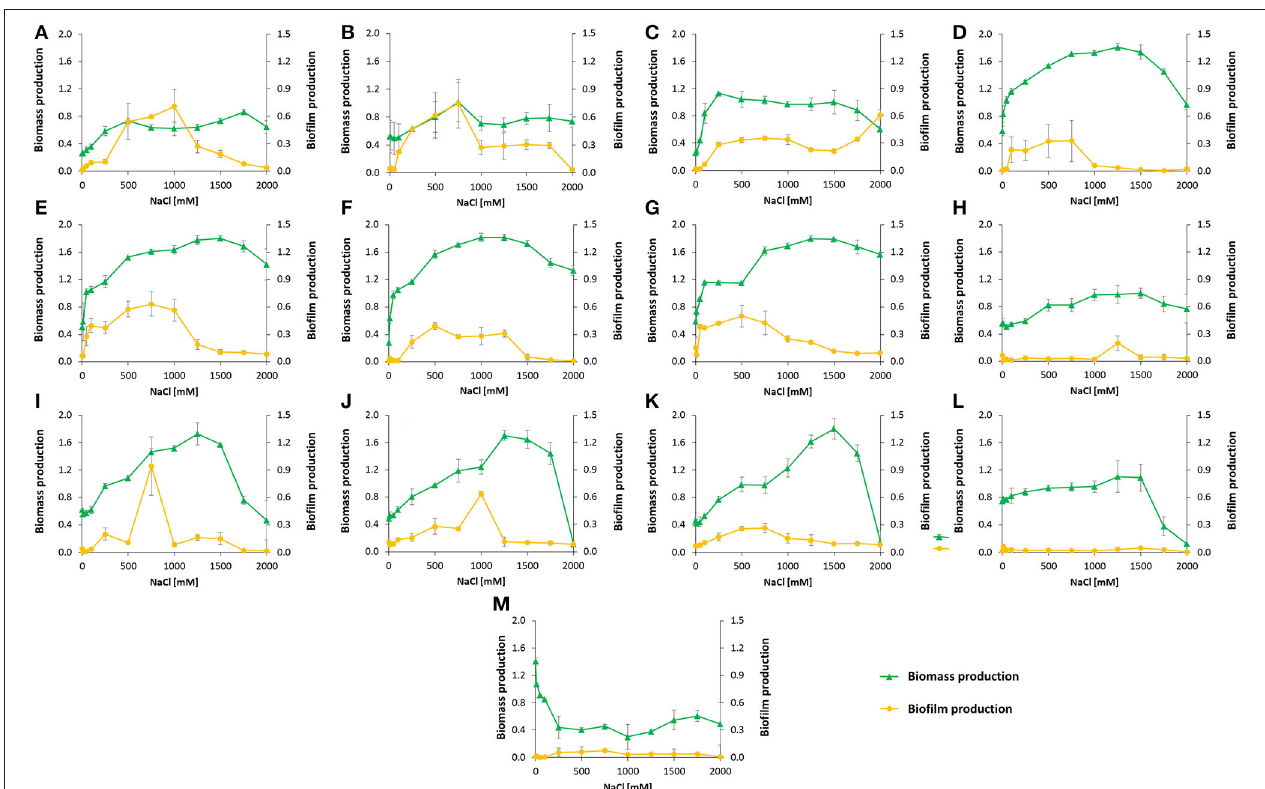
FIGURE 3 | Growth and biofilm production of 13 strains isolated from the Salar del Hombre Muerto: (A) Kushneria sp. T3.4, (B) Kushneria sp. T3.7, (C) Kushneria sp. T3.14, (D) Kushneria sp. T3.18, (E) Halomonas sp. 3R.3, (F) Halomonas sp. 3R.12, (G) Halomonas sp. AR39, (H) Pseudomonas sp. AN21, (I) Pseudomonas sp. AN23, (J) Pseudomonas sp. AN24, (K) Pseudomonas sp. AN25, (L) Planomicrobium sp. 3S.31, and (M) Pseudarthrobacter sp. ER25, cultured in nutrient broth with different NaCl concentrations (mM): 0, 10, 50, 100, 250, 500, 750, 1,000, 1,250, 1,500, 1,750, and 2,000, for 5 days at 30 ◦ C and 150 rpm. Each point marks the mean of maximum absorbance values measured at 600nm for biomass production and 595nm for biofilm production in each NaCl concentration ( n = 3), and error bars the standard